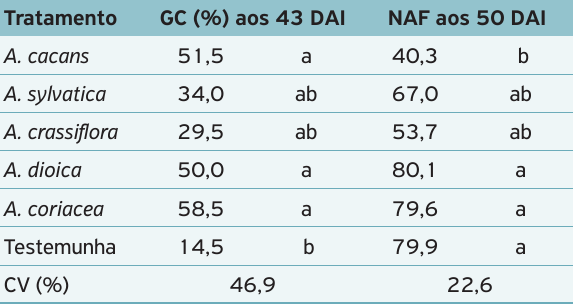
Figura 1. Germinação carpogênica (%) de S. sclerotiorum sob extratos metanólicos (1.000 ppm) de diferentes espécies de Annonaceae em função do tempo (dias) após a